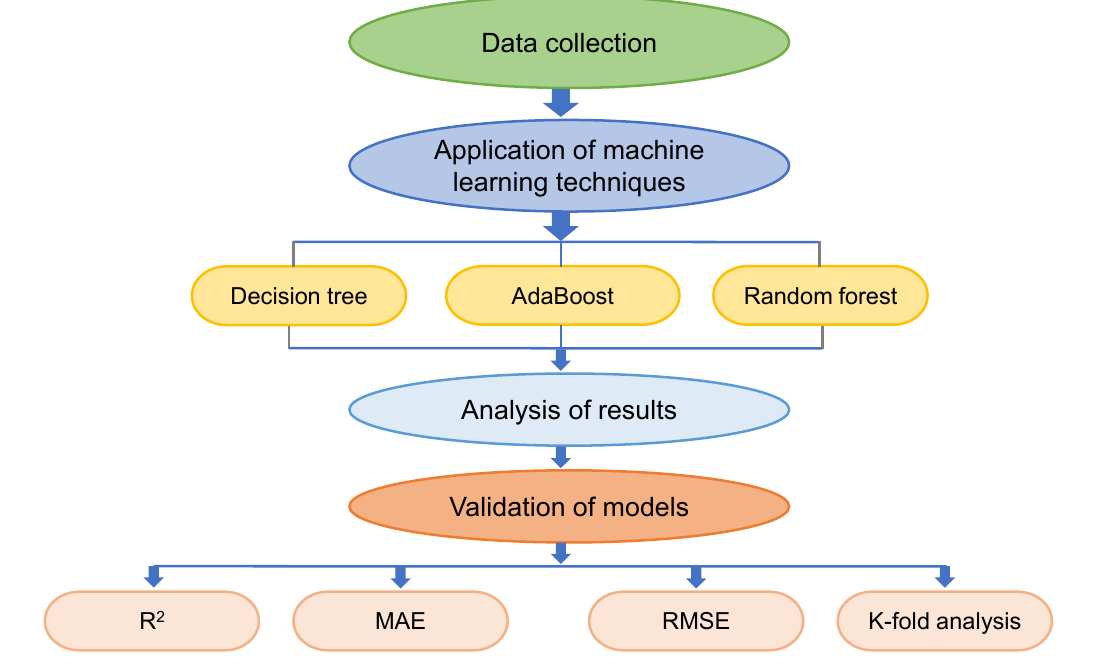
Figure 3. Flowchart of research methodology.